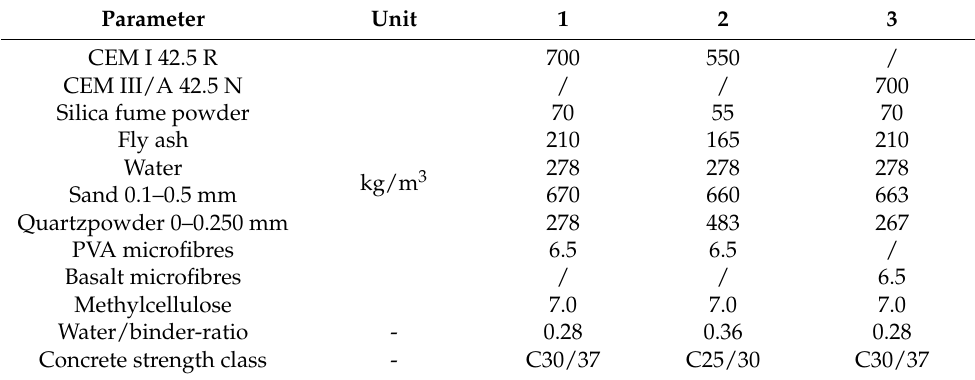
Table 1. Mixture designs of three different mortars for extrusion.